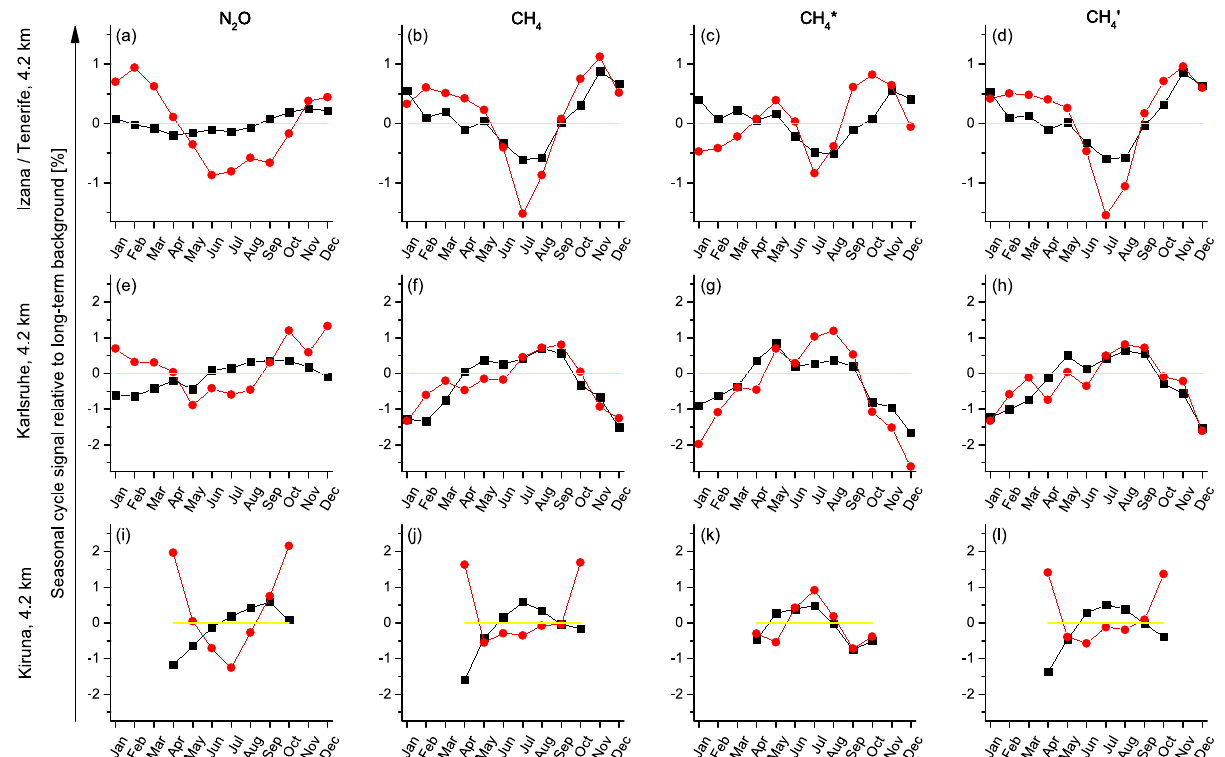
Figure 14. Same as Fig. 13, but for the daily mean MUSICA IASI products (4.2km retrieval, red) and coinciding NDACC FTIR product (4.2km retrieval, black): (a–d) for the surroundings of Tenerife Island; (e–h) for the surroundings of Karlsruhe; (i–k) for the surroundings of Kiruna; (a) , (e) and (i) for N 2 O; (b) , (f) and (j) for CH 4 ; (c) , (g) and (k) for CH ∗